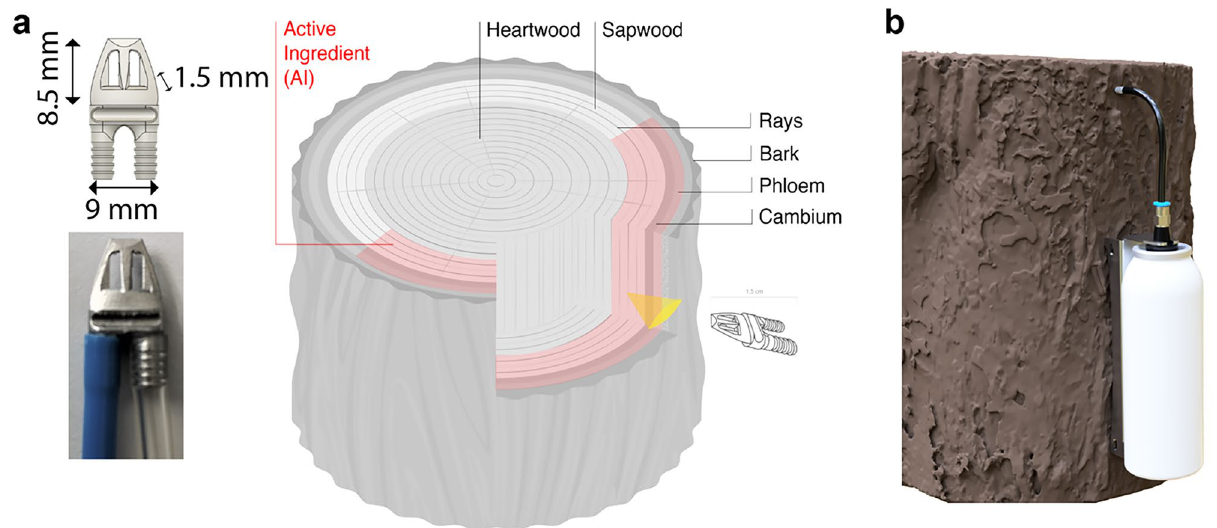
Figure 7. Endotherapy device ( a ) An arrow-shaped metal component of the TIPS Injection System was designed to inject active ingredients precisely in the plant vascular system of olive trees. ( b ) Modular spray- can device of the TIPS Injection System applied to an olive tree. The system allows a low-pressure release of compounds.